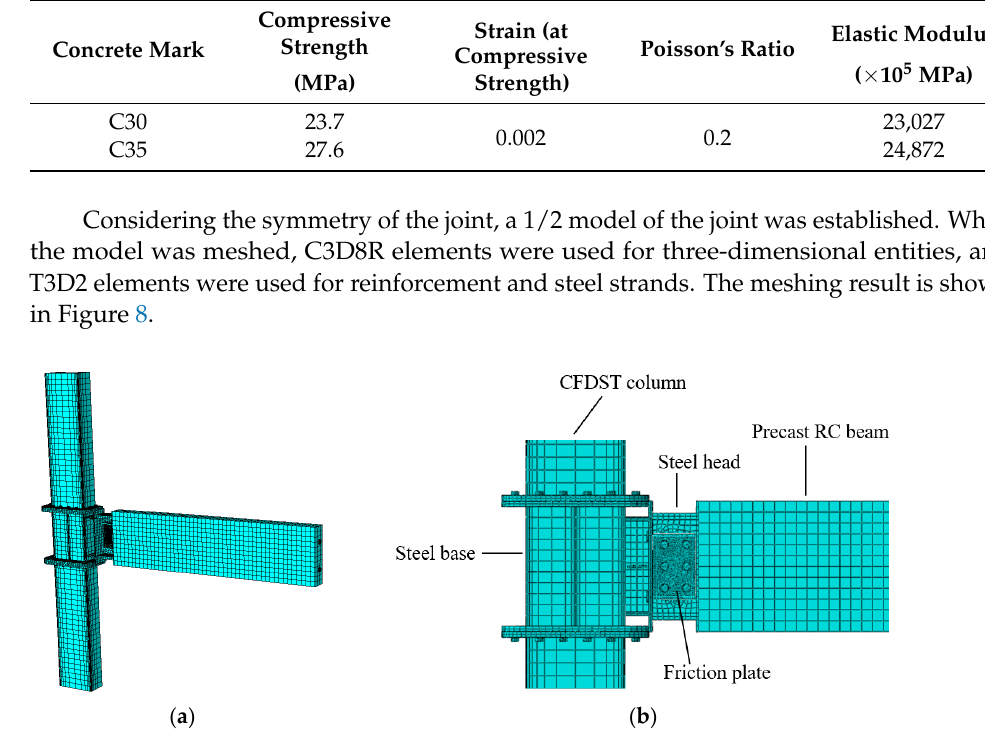
Figure 8. Meshing of the joint: ( a ) Overview of the joint; ( b ) Details of the joint.